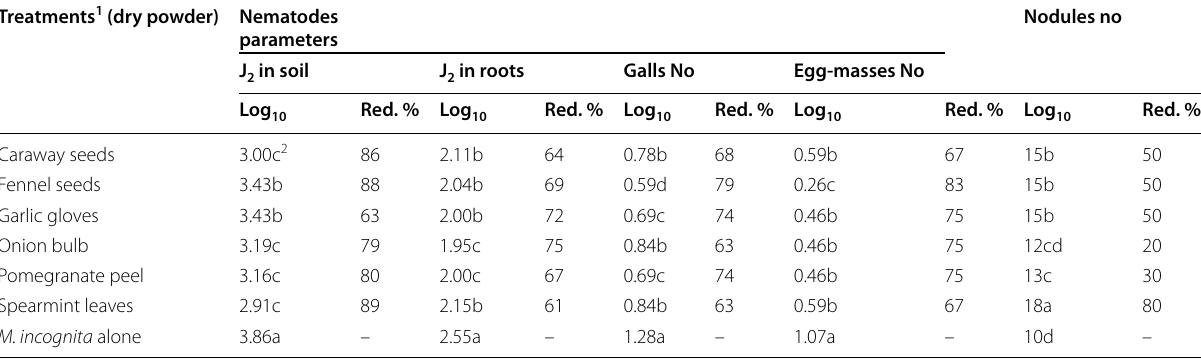
Table 3 Effect of dry powder plant materials on M. incognita parameters and Rhizobium bacterial nodules number in pea roots system in pots, under greenhouse